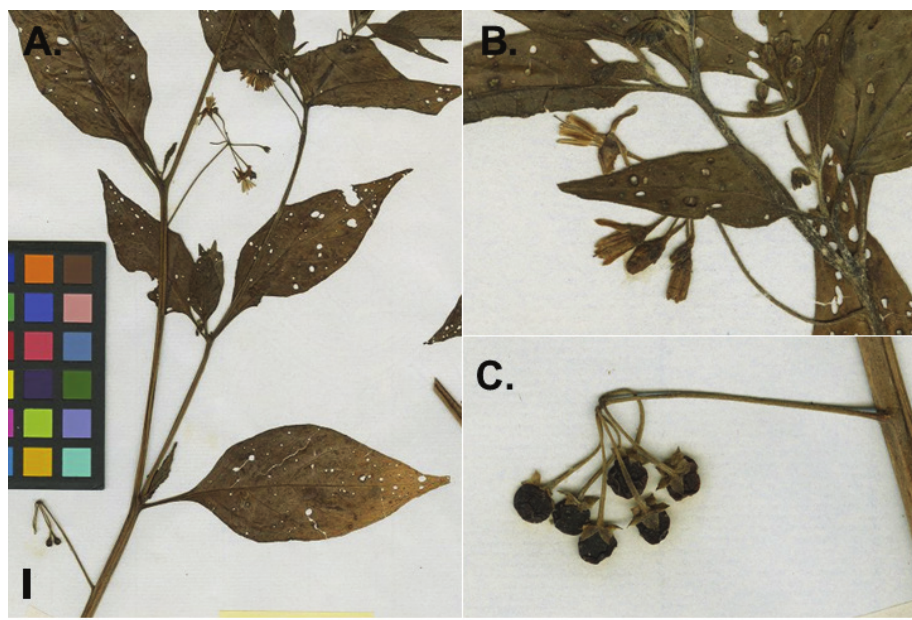
Figure 24. Solanum macrotonum Bitter. A Reproductive stem B detail of inflorescence C detail of in- fructescence ( A–C Moritz 1643 , K000585559). Scale bar in A : 1